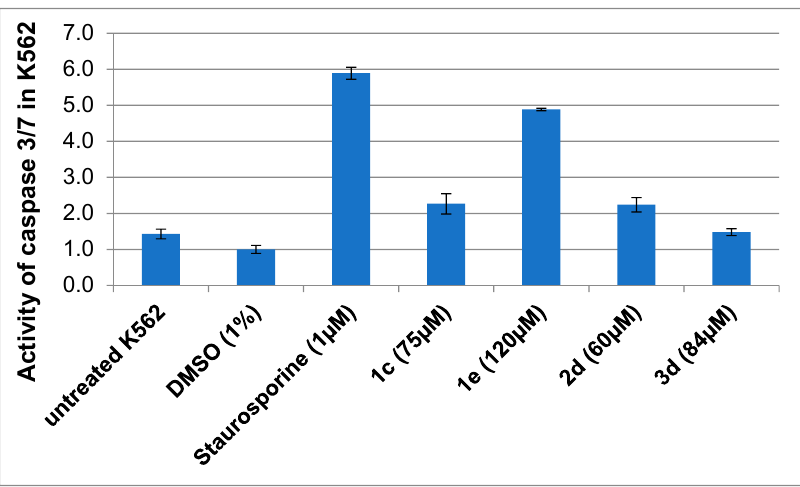
Figure 5. Activity of caspase 3 and 7 in K562 cells treated with the test benzofurans 1c , 1e , 2d , 3d , or staurosporine for 18 h. Apoptosis was determined by Apo-ONE ® Homogeneous Caspase-3/7 Assay (Promega, Madison, WI, USA). Abbreviations: DMSO—K562 cells treated with 1% DMSO. The caspase activation level in cells exposed to 1% DMSO was normalized to 1.0. Mean values +/ − SD are